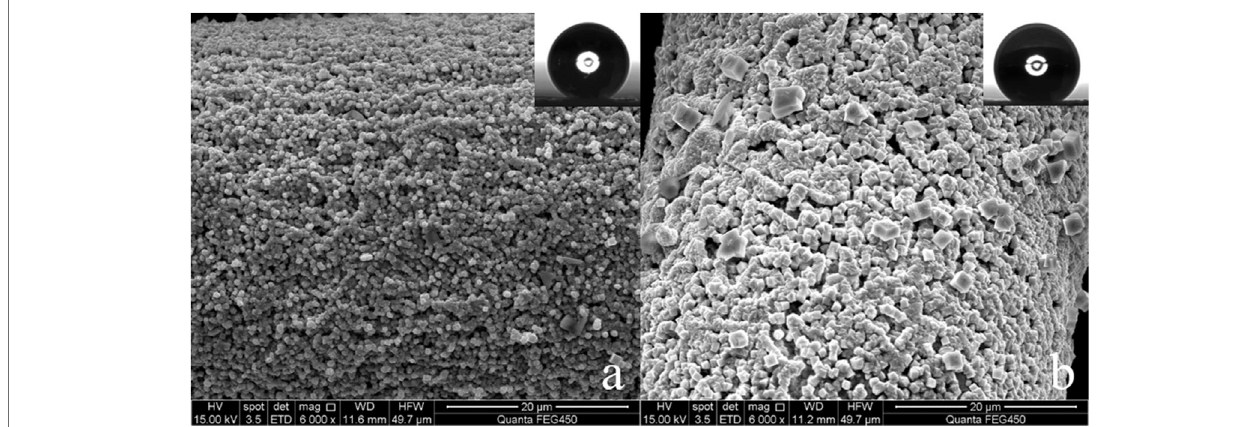
FIGURE 6 | Copper mesh surface with different WCA.